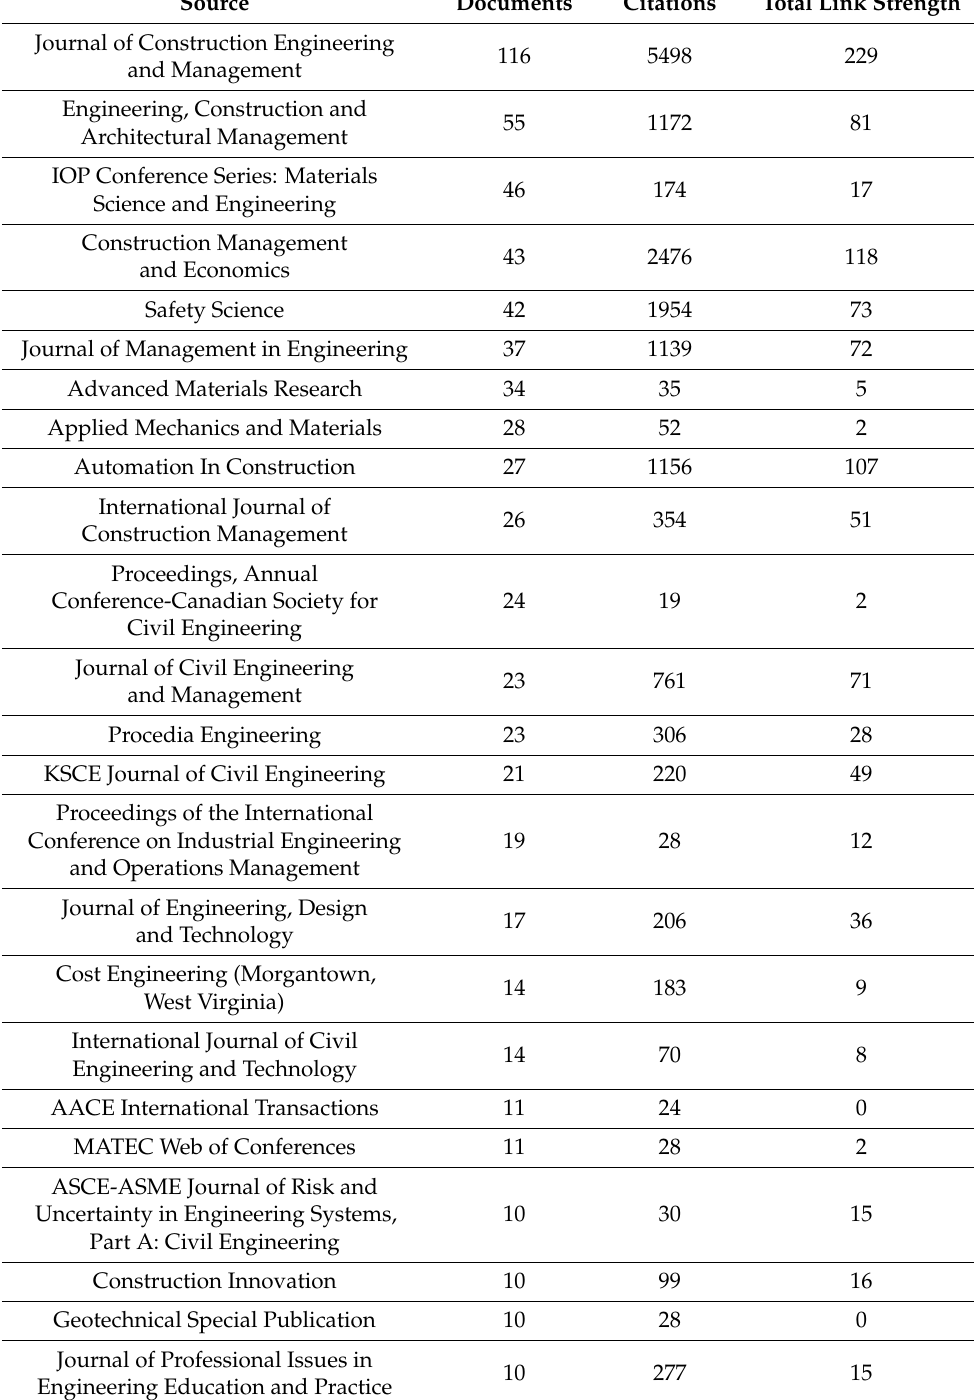
Table 4. Table 3. Outlets of risk management in construction